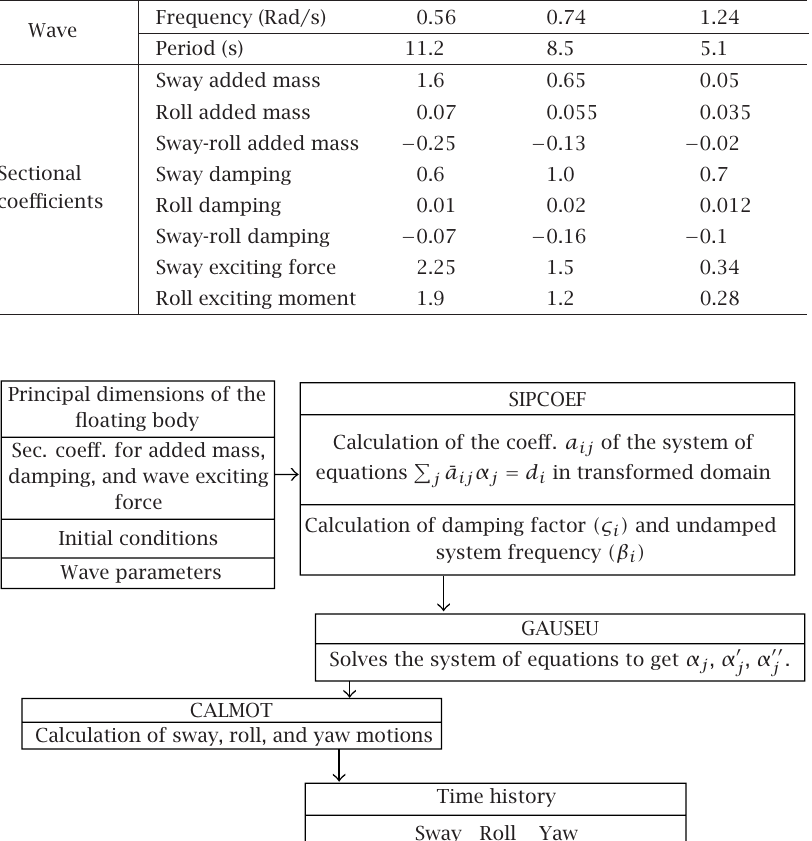
Table 5.1 . Computed sectional coefficients of the floating body.